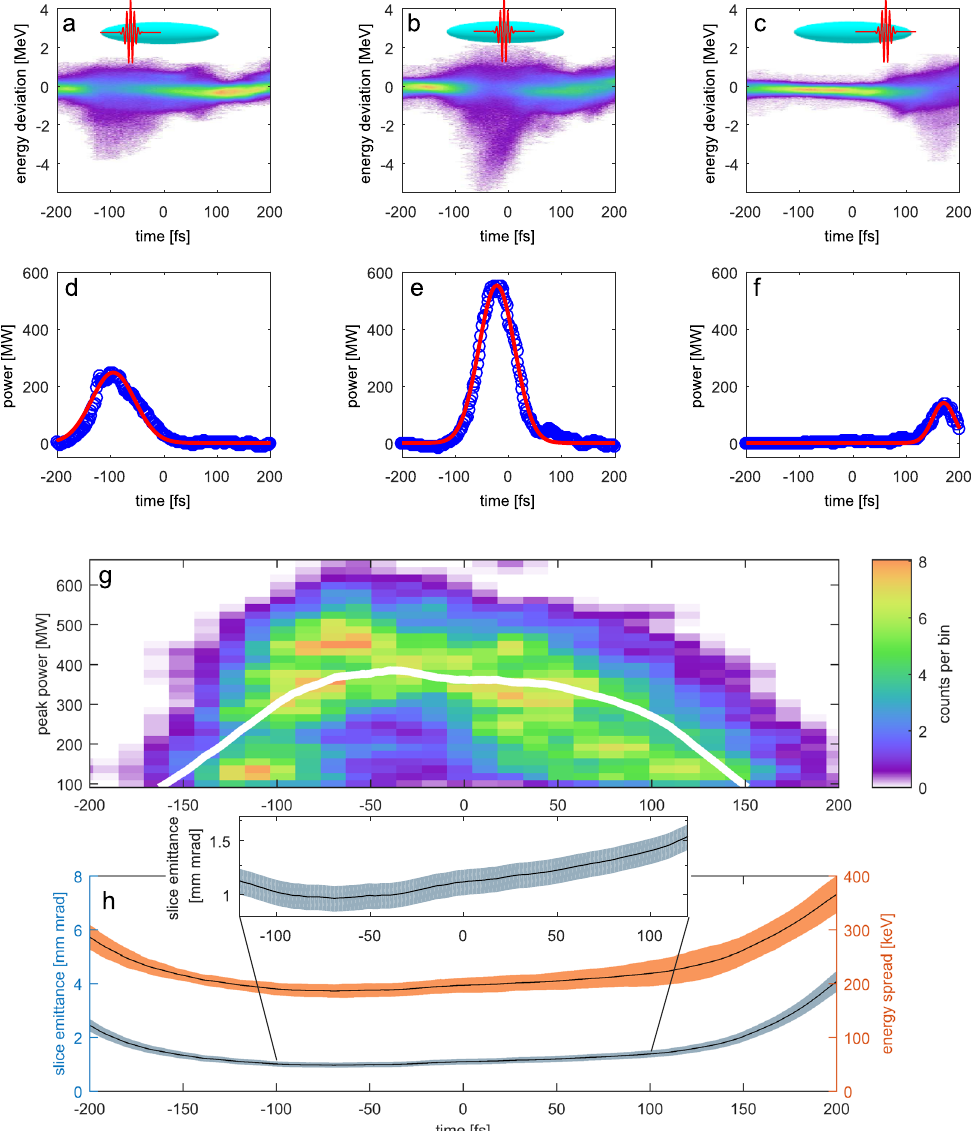
Figure 4. The longitudinal phase space distribution of ultra-relativistic electron bunches for three different relative timings ( − 97 fs, − 21 fs and 168 fs) between seed pulse and electron bunch are shown in panels ( a – c ). The panels ( d – f ) display the corresponding reconstructed power profiles. The two-dimensional histogram of panel g shows the correlation between seeded FEL peak power and the relative position of the seed laser pulse maximum in time. The histogram uses Gaussian smoothing with an rms size of 1 pixel. The white line indicates the seeded FEL performance predicted with the semi-analytical Ming-Xie formalism using electron beam parameters extracted with no FEL action at all. Panel h shows the measured energy spread from the unmodulated reference bunches and the reconstructed emittance used to calculate the prediction in panel g. The inset shows the longitudinal profile of the slice emittance in the core region of the bunch. It has its minimum at about − 50 fs and increases towards the outer wings of the scan in agreement with the measured reduction of the emitted FEL power in these